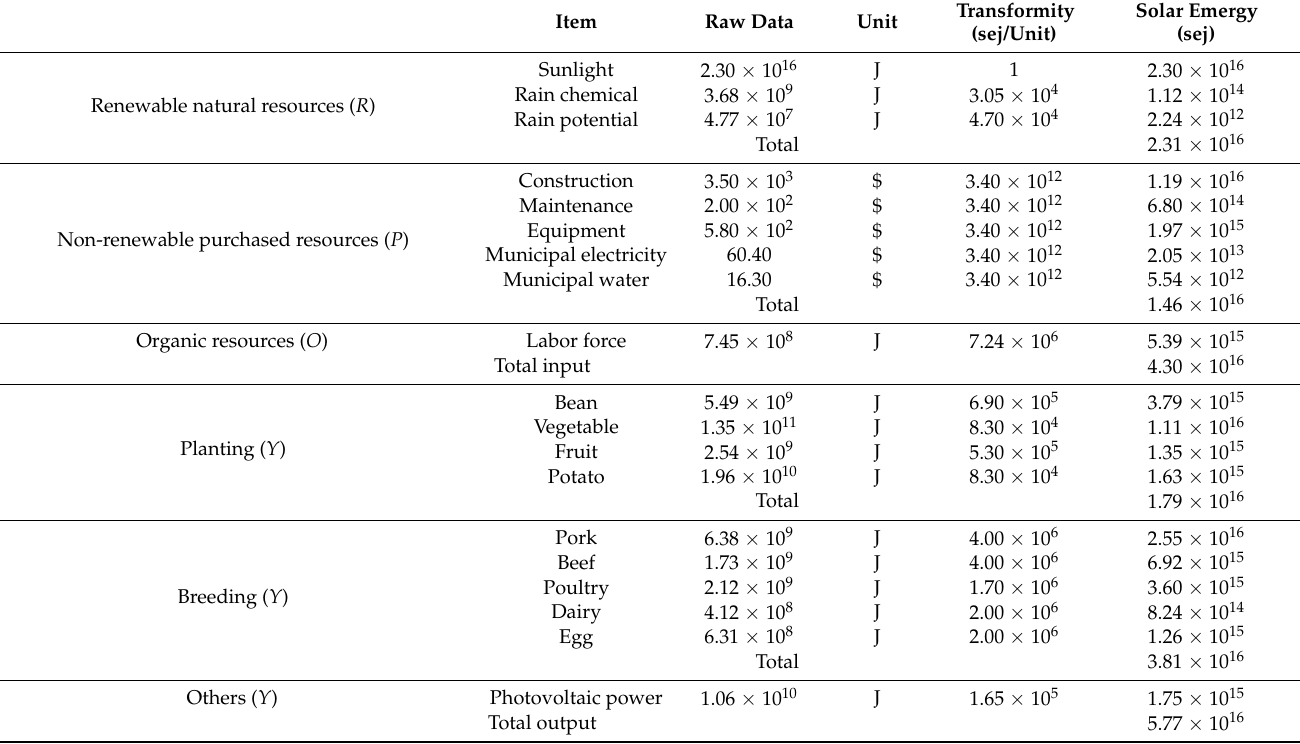
Table 2. Emergy input and output of the courtyard